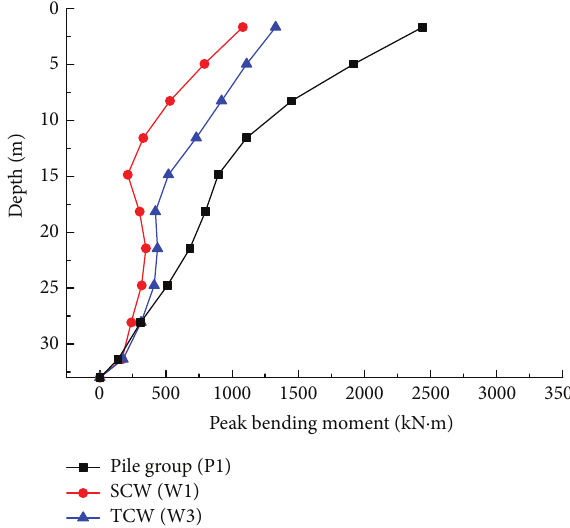
Figure 19: Peak bending moment (PBM) of three